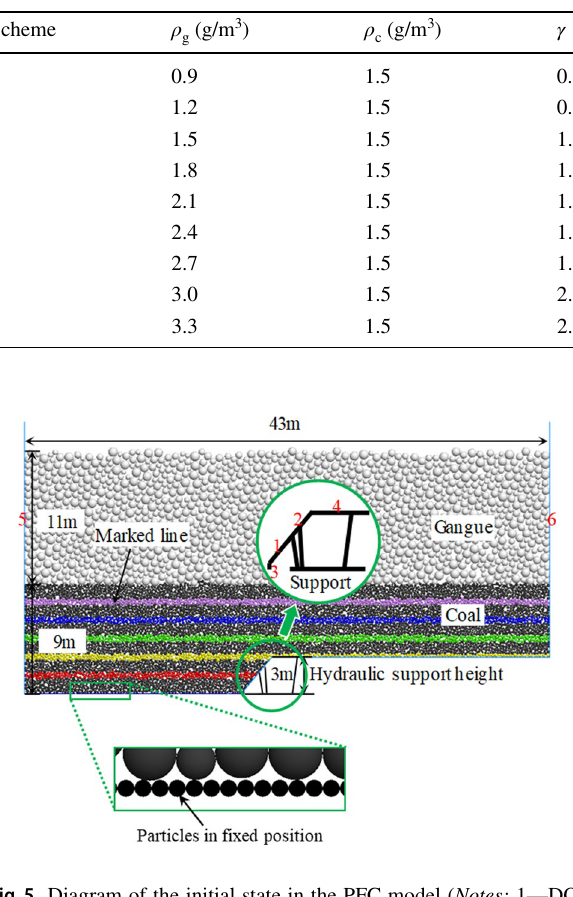
Fig. 5 Diagram of the initial state in the PFC model ( Notes: 1—DO; 2—shield beam; 3—back edge of the rear AFC; 4—canopy; 5—left boundary of the model; 6—right boundary of the